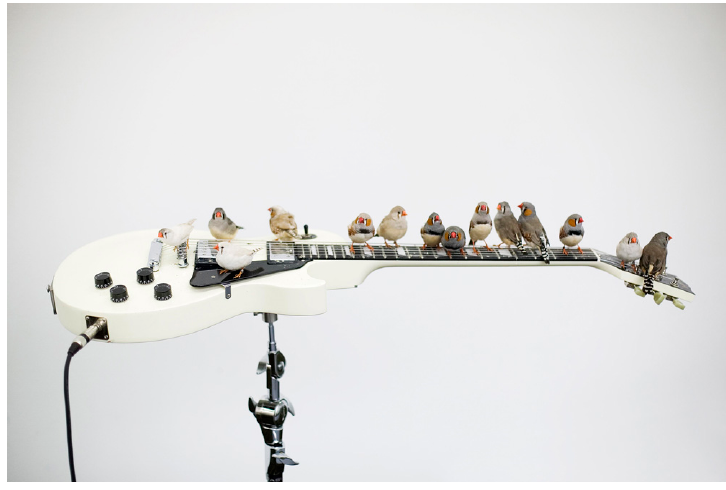
Figure 3. From here to ear by Celeste Boursier-Mougenot [32].